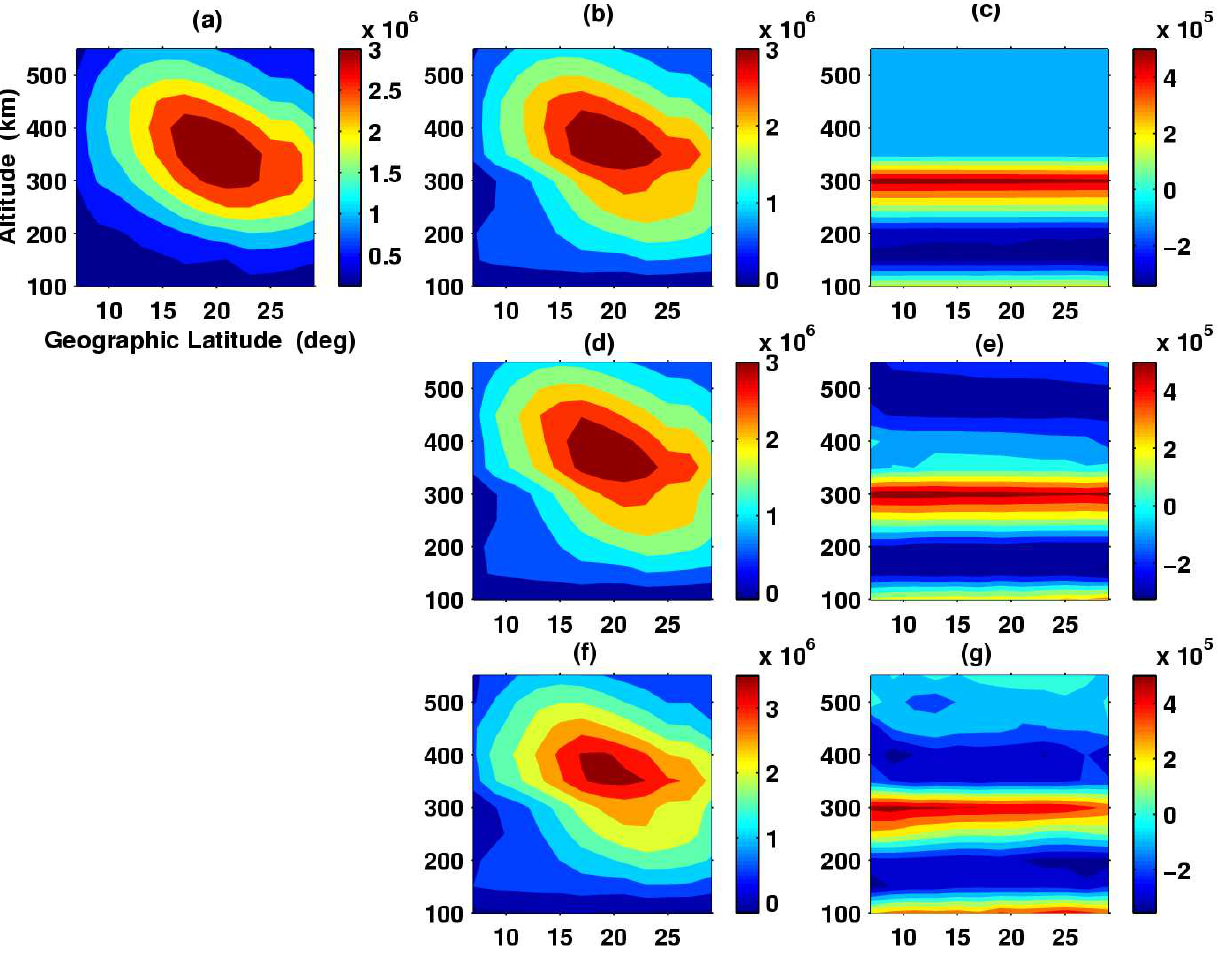
Fig. 11. ( a ) Model ionosphere with an enhanced electron density. ( b ) The reconstructed image with a bias error of 1% of the minimum TEC when the 3 smallest singular values are omitted from the solution. ( d ) Reconstruction with a bias error of 5% of the minimum TEC when the 4 smallest singular values are truncated. ( f ) The reconstruction with random errors ranging from 0.001% to1% of the average TEC added to input data and with the 5 lowest singular values truncated. ( c , e , g ) The corresponding differences from the model in Fig. 11a.